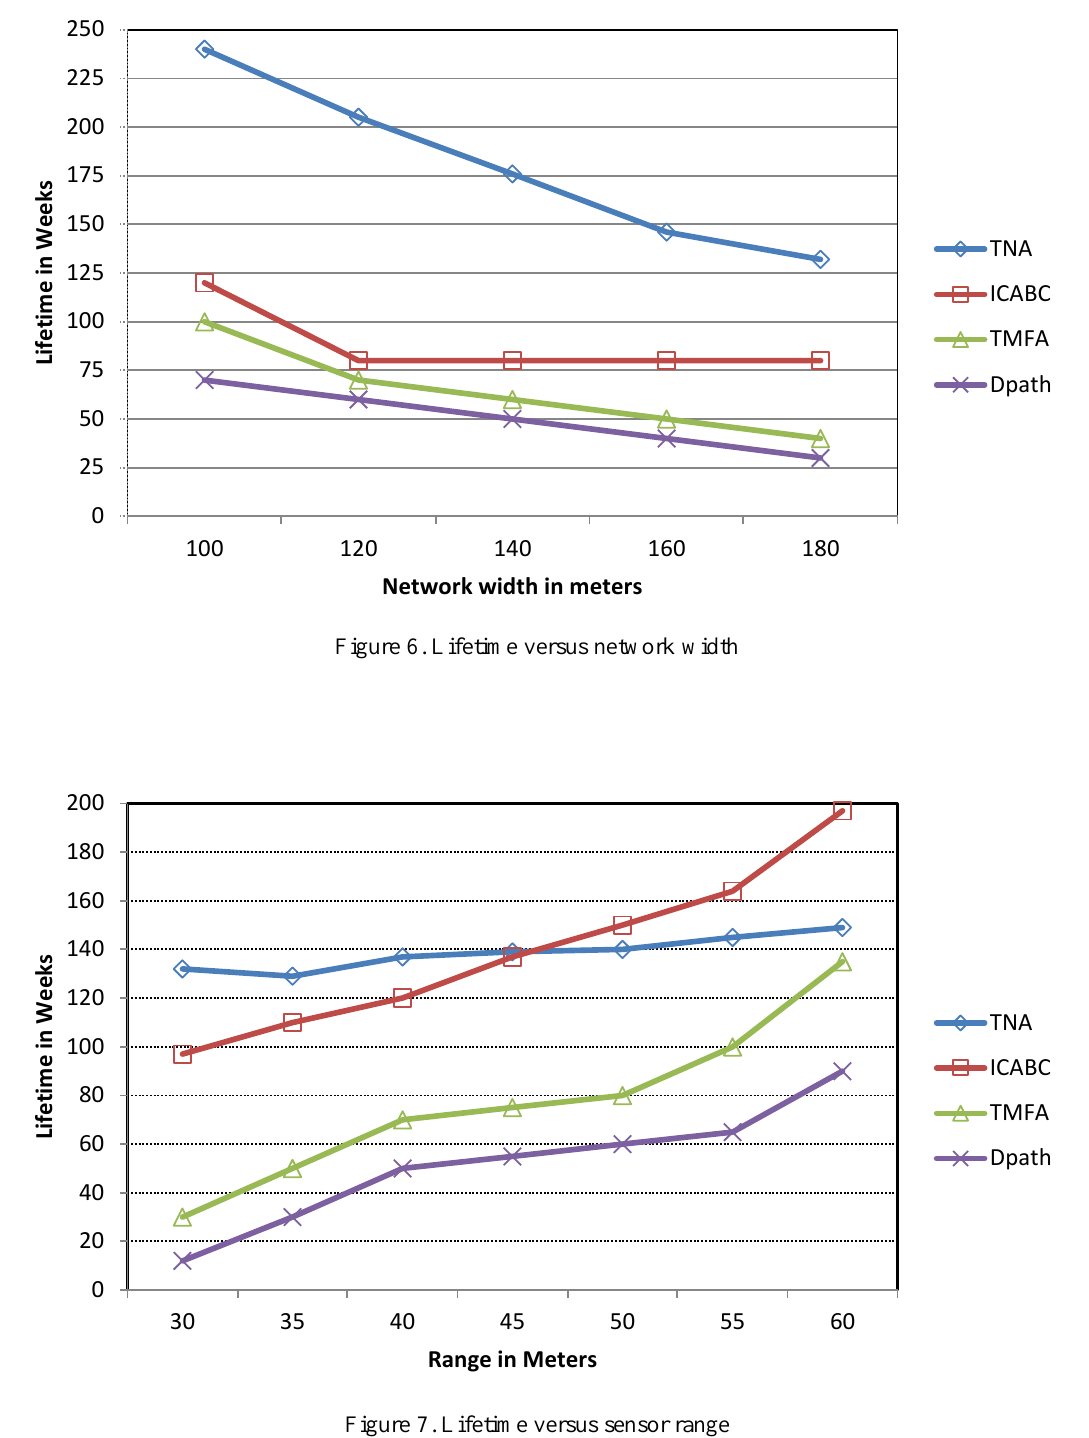
Figure 7. Lifetime versus sensor